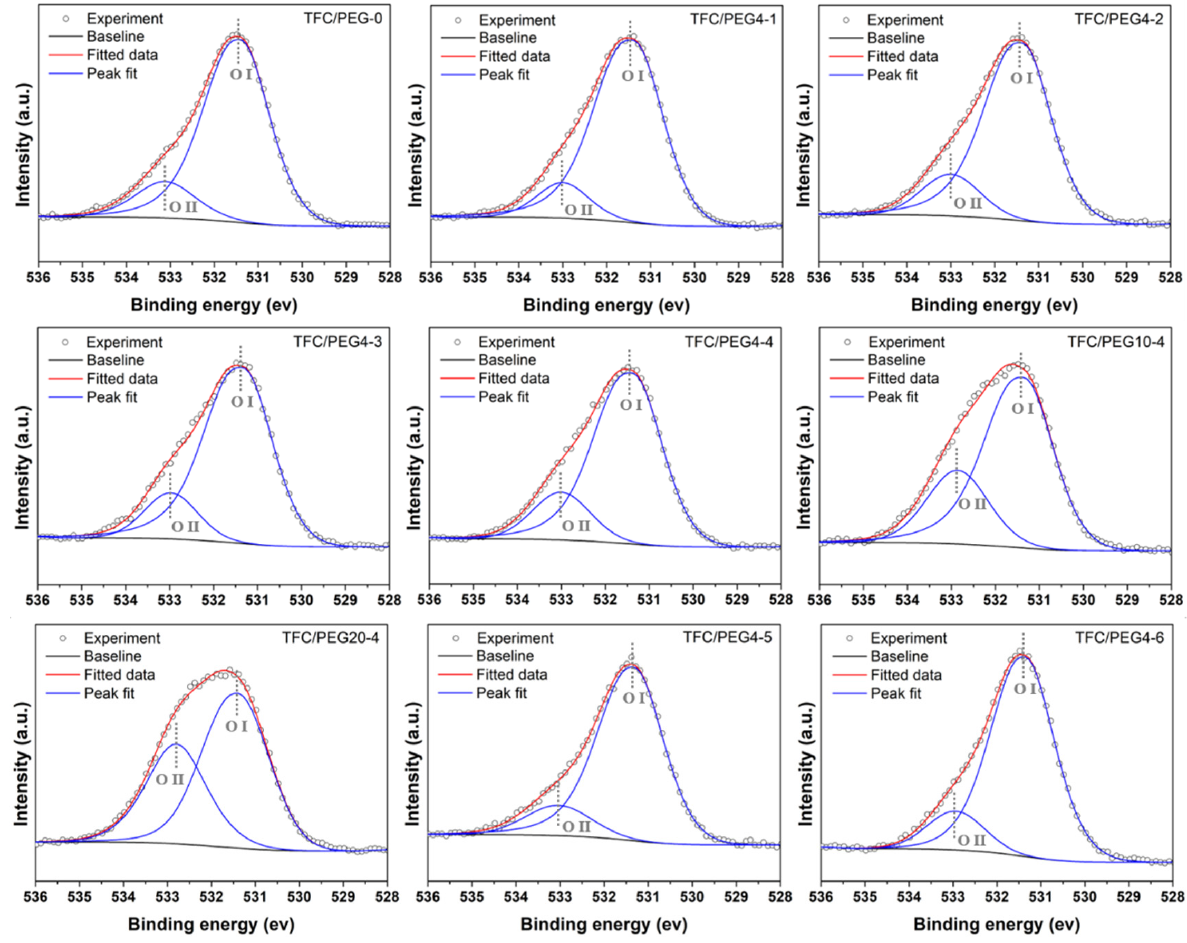
Figure 6. Convoluted high-resolution O 1s spectra of PSU/PEG supported TFC-FO membranes. Table 3. XPS surface analysis of PSU/PEG supported TFC-FO membranes.